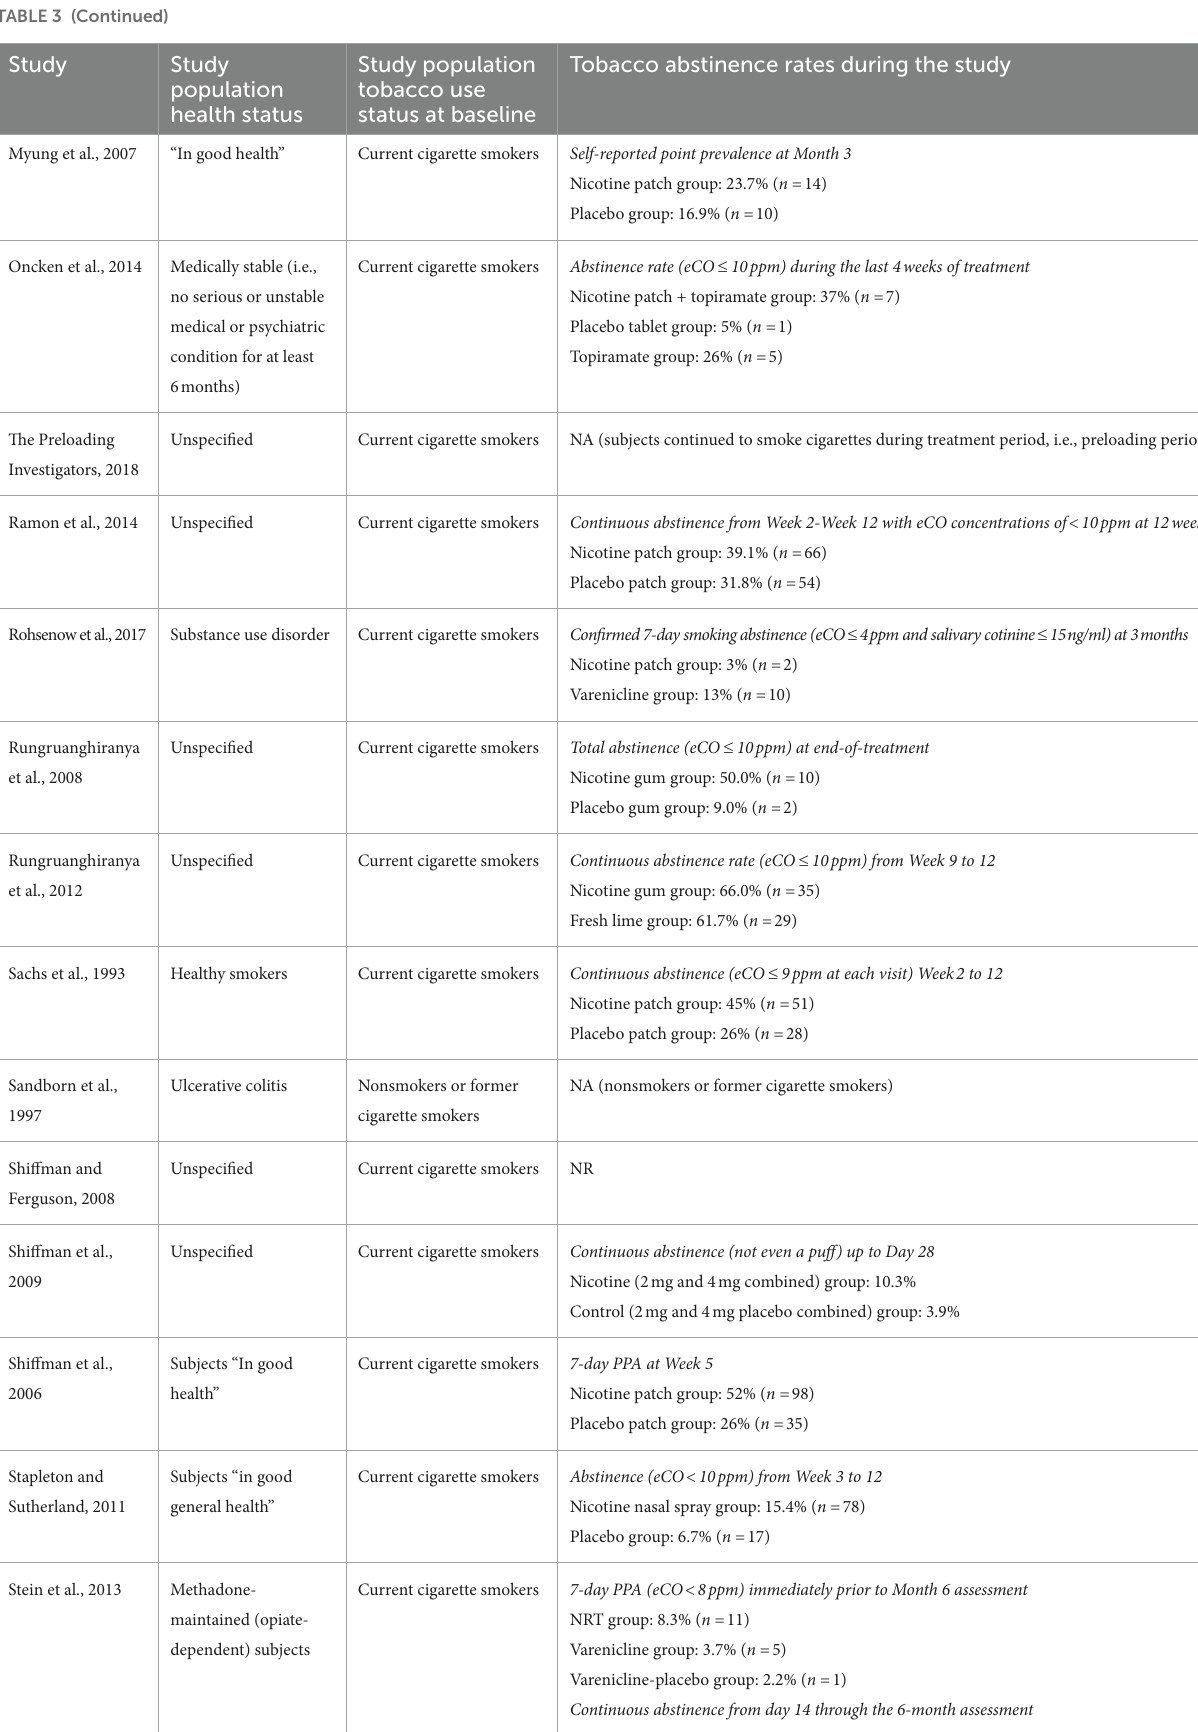
Varenicline group: 3.7% ( n = 5) Varenicline-placebo group: 2.2% ( n = 1) Continuous abstinence from day 14 through the 6-month